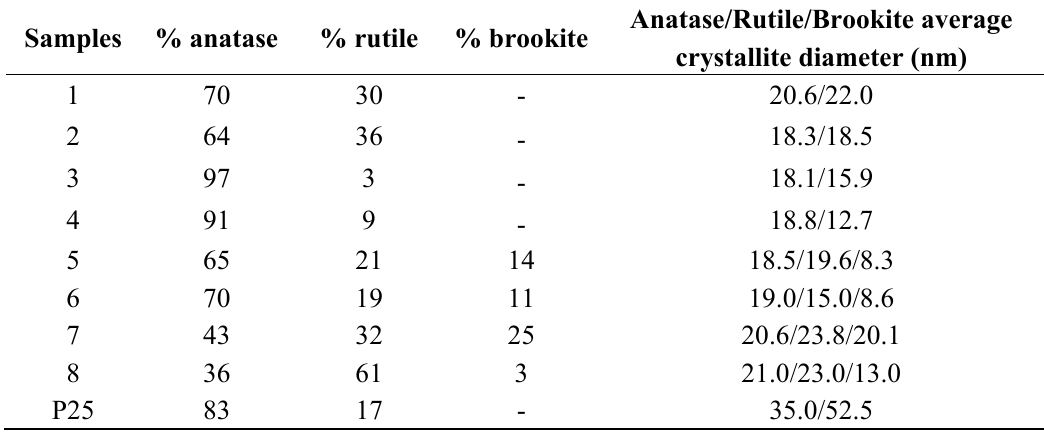
Table 2. Relative phase composition and crystallite diameters determined by Rietveld method for samples 1–8 and